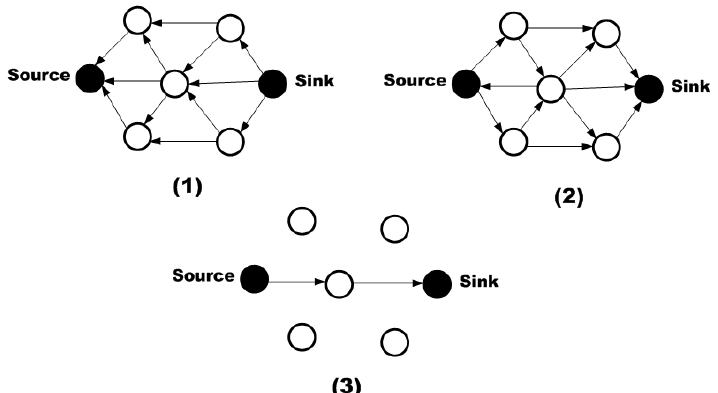
Figure 8. The operation of Directed Diffusion